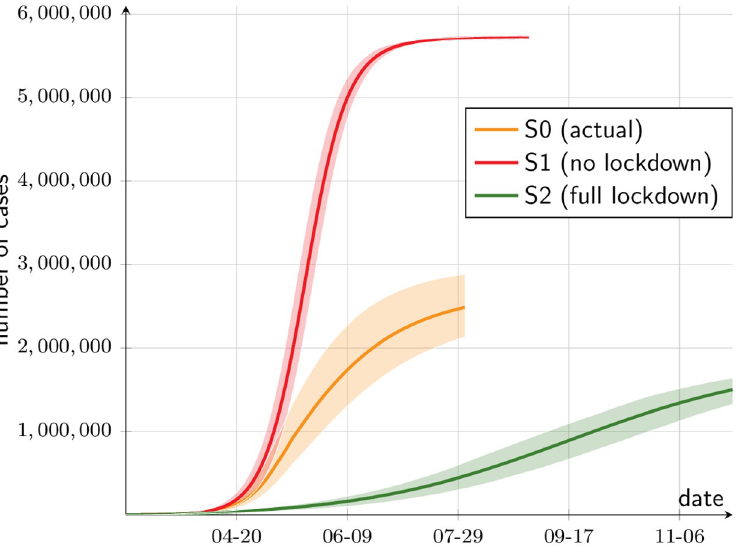
Fig 9. Cumulative cases in counterfactual scenarios. The lines depict the means across simulations, and the band around them the 90 percent confidence interval.